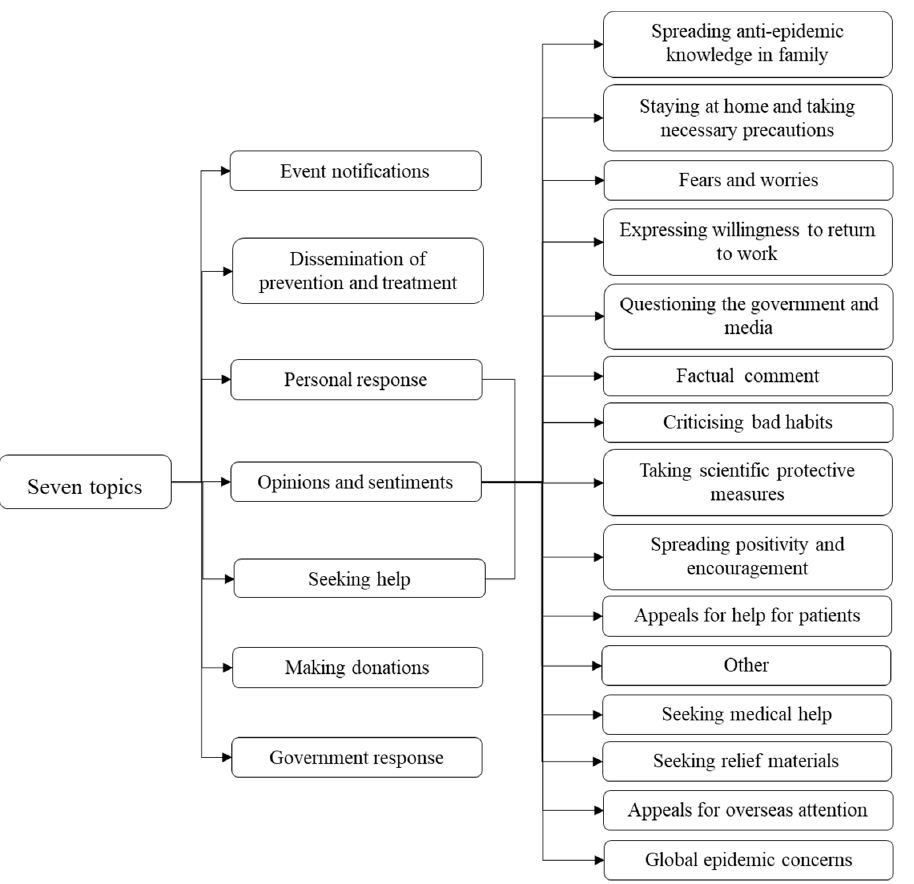
Figure 2. The classification of COVID-19-related topics and sub-topics.